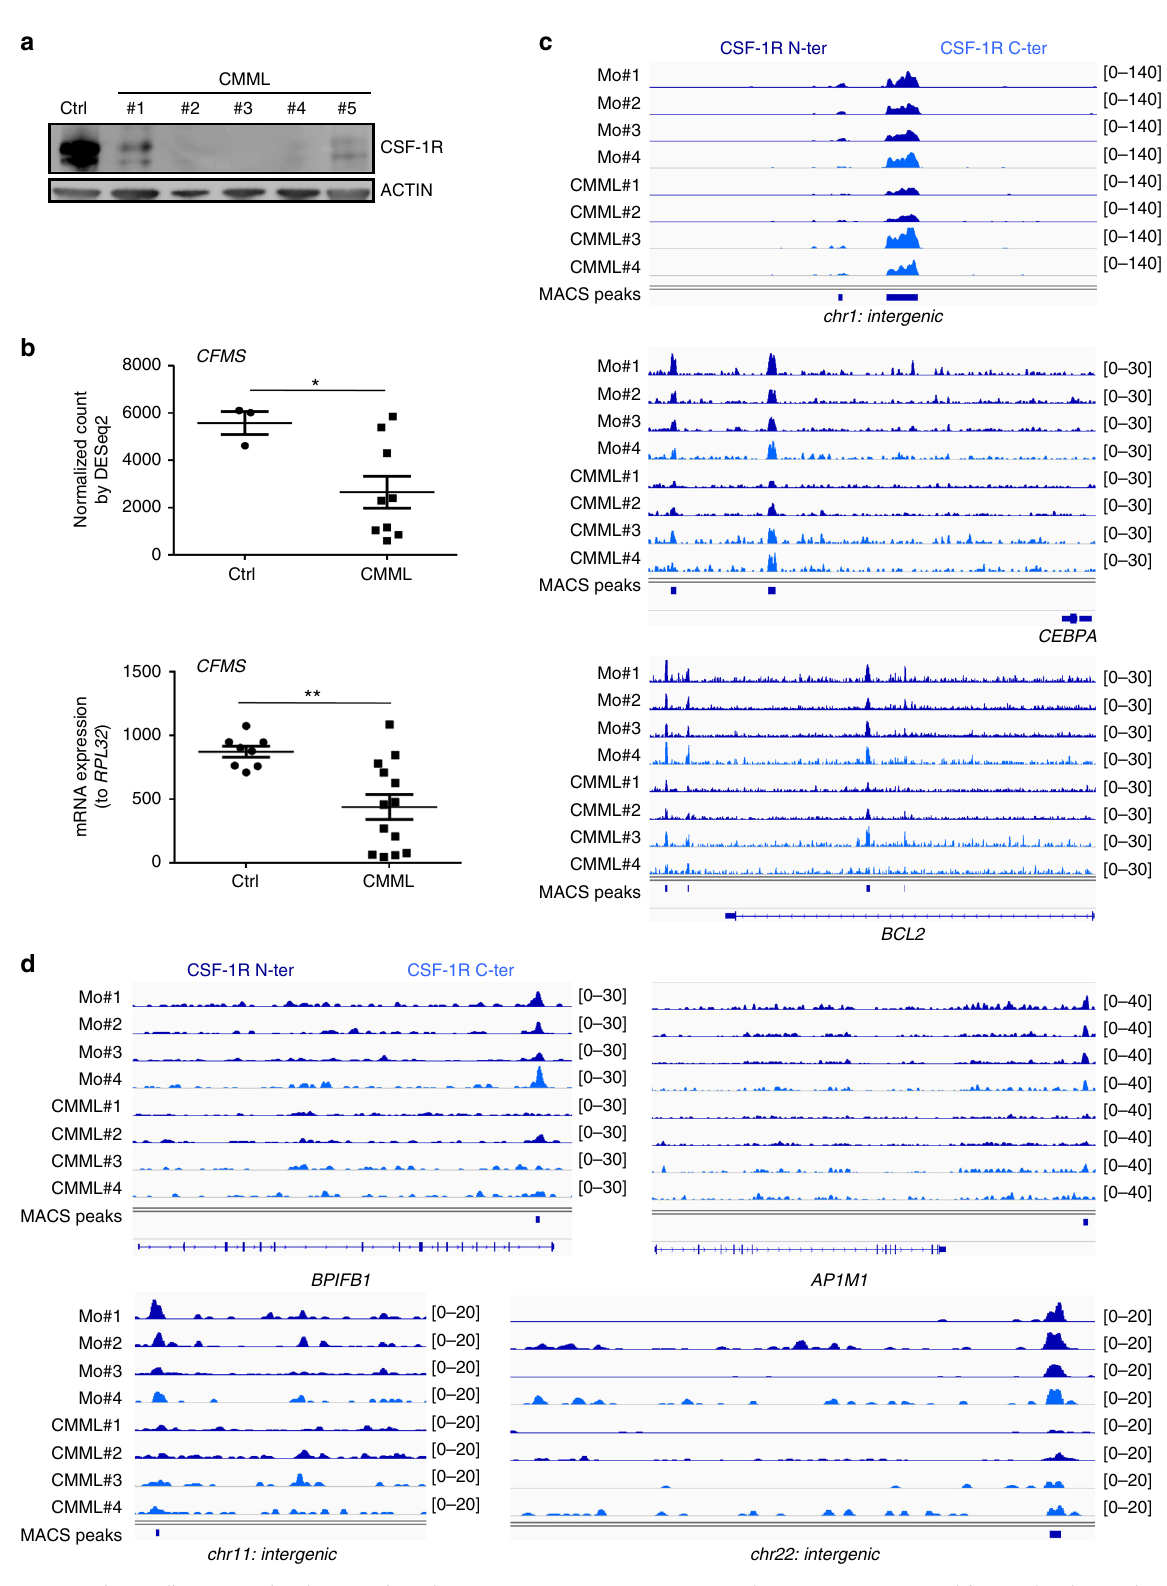
Fig. 9 CSF-1R is abnormally expressed and recruited on chromatin in CMML monocytes. a Total proteins were extracted from isolated control or CMML monocytes and analyzed by immunoblotting with antibodies that recognize CSF-1R and actin. b CFMS expression was assessed by RNA-sequencing and qPCR in monocytes of 9 and 13 CMML patients, respectively, compared with 3 and 8 control buffy coats (Ctrl), respectively (mean + / − SEM, Mann – Whitney test: * P < 0.05, ** P < 0.01). c ChIP-Seq experiments showing CSF-1R peak localization on intergenic area on chromosome 1 (chr1: intergenic), upstream of CEBPA and on BCL2 genes that are conserved in control and CMML monocytes. d ChIP-Seq experiments showing CSF-1R peak localization on BPIFB1 , downstream of AP1M1 and on intergenic area on chromosome 11 and 22 (chr11: intergenic and chr22: intergenic) that can be lost in CMML compared with healthy donor monocytes (CSF-1R N-ter: sc-46662 monoclonal antibody in dark blue, CSF-1R C-ter: sc-692 polyclonal antibody in light